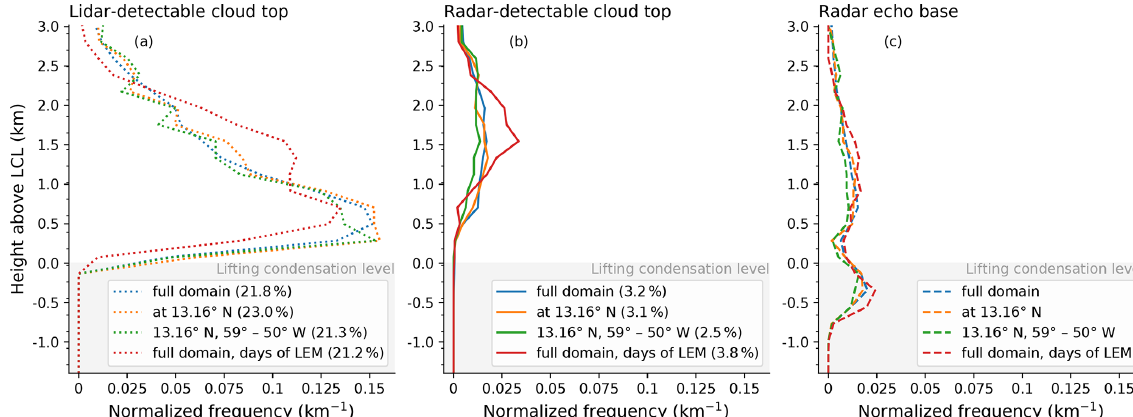
Figure C3. Comparison of cloud top and base heights in different spatial and temporal subsamples of the 1.25km SRM dataset. Shown are the full domain (as in Fig. 5), the data near the same latitude (13.16 ◦ N) as LEM meteogram locations, the data near the same latitude and longitude range (59–50 ◦ W) as LEM meteogram locations, and the full spatial domain but only the days with available LEM output: (a) lidar-detectable cloud top height, (b) radar-detectable cloud top height, (c) radar echo base height. Total shallow 2D cloud coverage detected by lidar and radar in each dataset are given in the